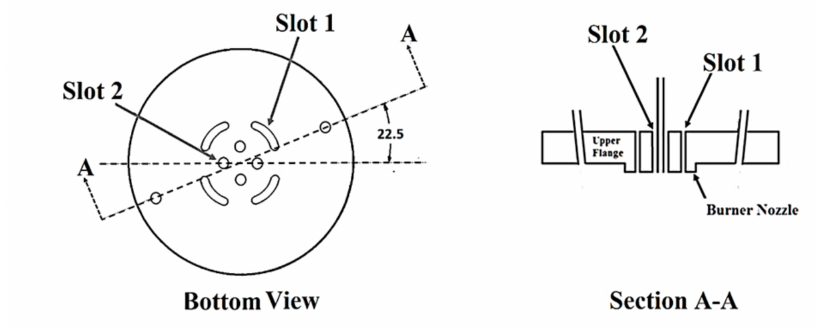
Figure 8. Schematicdiagramshowingthefuel / oxygenburner: Leftfigure -Bottomview. Rightfigure -Cross section at A-A. (The figure is adapted from Sohn et al. [31]).